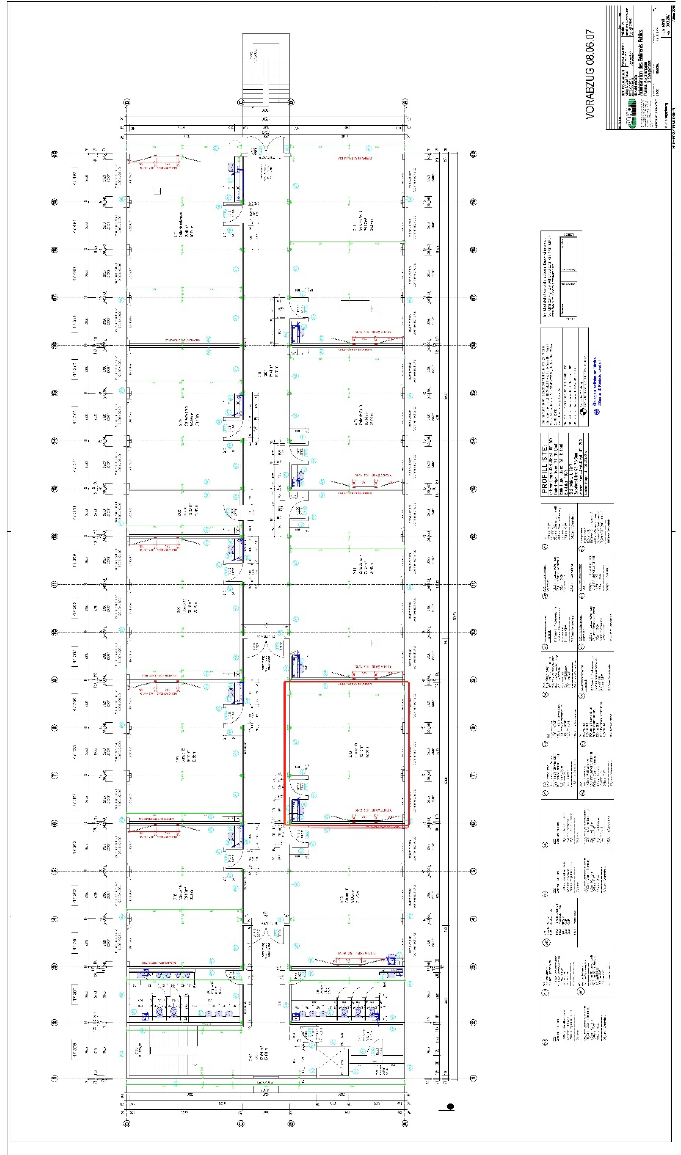
Figure A3. Drawing of the second floor of Nordstadt Lycee. The red box indicates the analysed room.